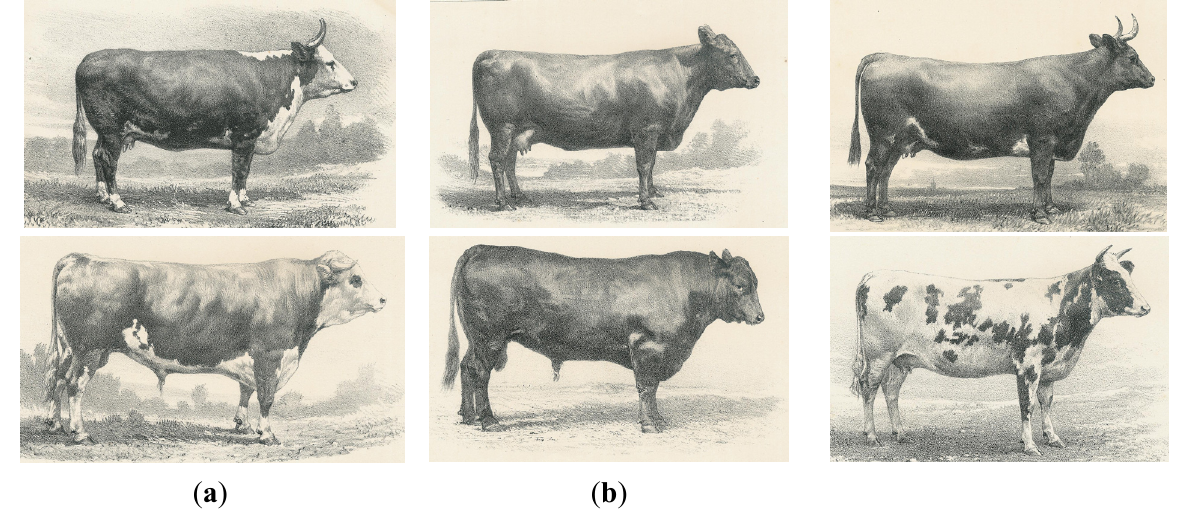
Figure 14. Other British breeds [142] ( a ) Hereford cow (1855) and Hereford bull (1856); ( b ) Aberdeen-Angus cow (1855) and bull (1856); ( c ) Ayrshire cows without (1855) and with (1856) the current spotted